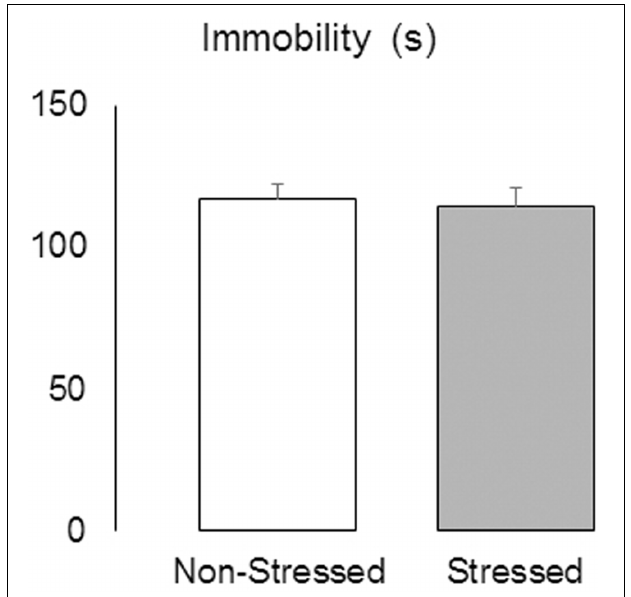
FIGURE 5 | Immobility (s) measured in the tail suspension test in non-stressed controls and socially defeated mice 9 days after the last confrontation. Data are mean ± SEM. n = 11 − 12 mice per group.